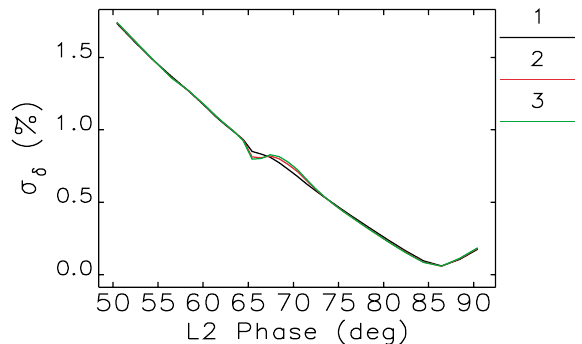
FIG. 10. (Color) Fractional rms momentum spread as a function of phase of the precompressor accelerator without CSR in drifts (1), with CSR in drifts using the overtaking length as the expo- nential decay length (2), and with CSR in drifts using Saldin’s Eqs. (53) and (54) (3).